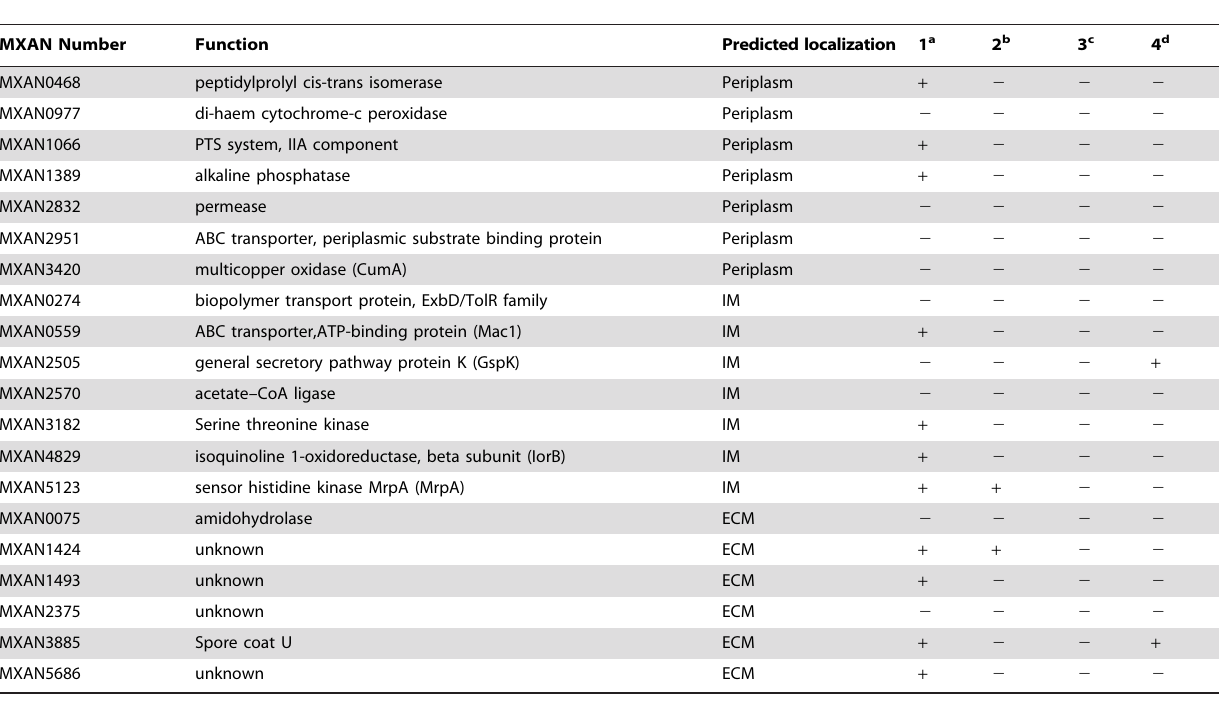
Table 2. M. xanthus IM, periplasmic and ECM proteins 1